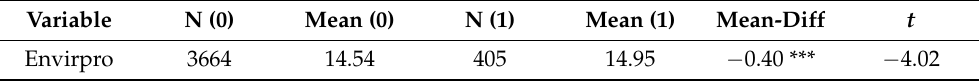
Table 3. T -test between groups.